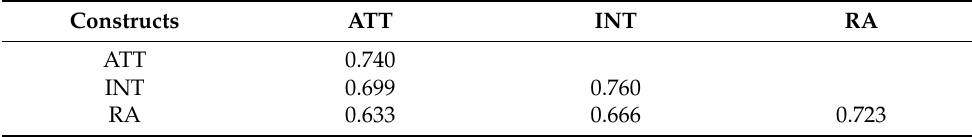
Table 8. Discriminant Validity (Fornell–Larcker Criterion).